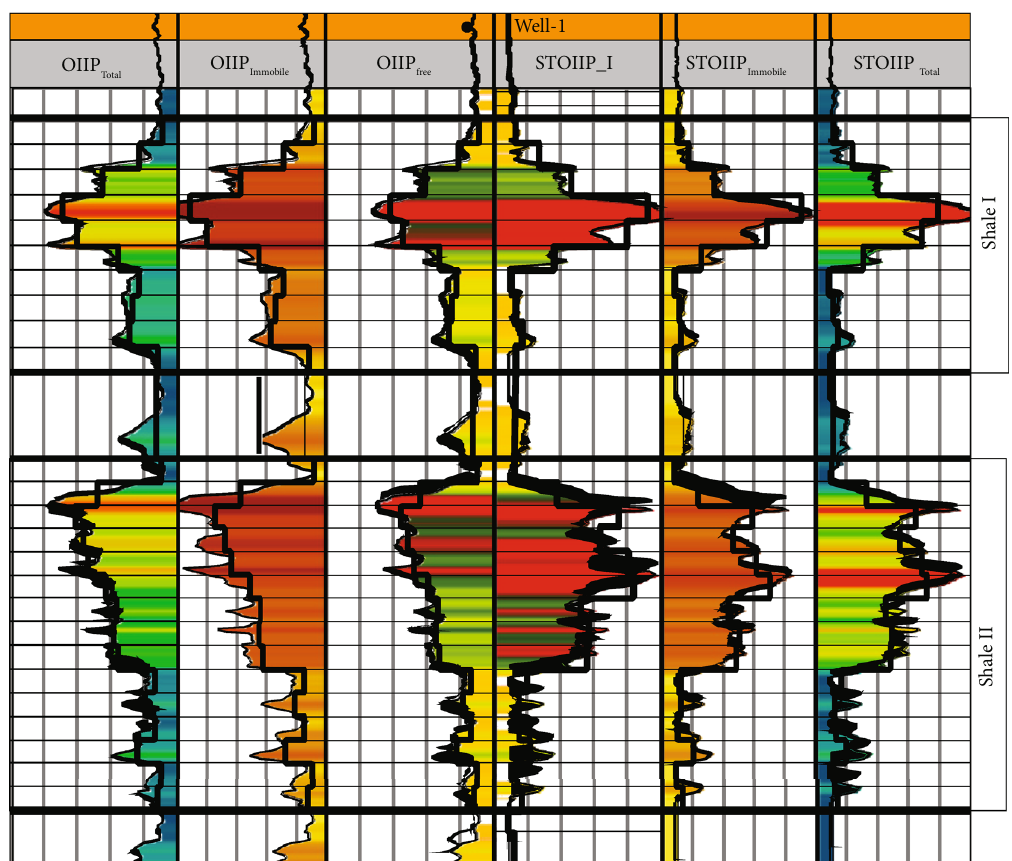
Figure 11: Comparison of oil-in-place estimation results obtained with geochemical and standard volumetric methods: the fi rst three tracks refer to the results of the geochemical method, accordingly: OIIP Total , OIIP Immobile , and OIIP Free ; tracks 4-6 present estimates of standard volumetric method, accordingly: STOIIP Free , STOIIP Immobile , and STOIIP Total .